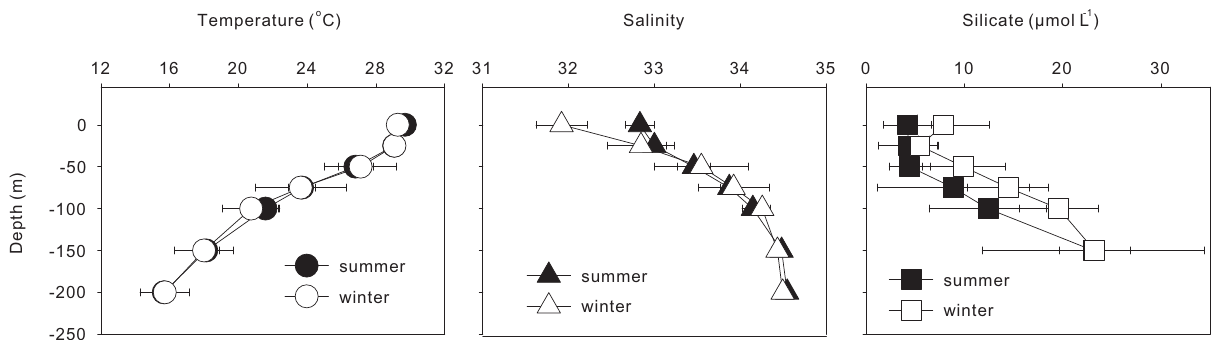
Figure 2. Vertical profiles of seawater temperature, salinity, and silicate concentration in the southern South China Sea during May to June 2009 (summer) and November 2010 (winter). The error bar indicates standard deviation.